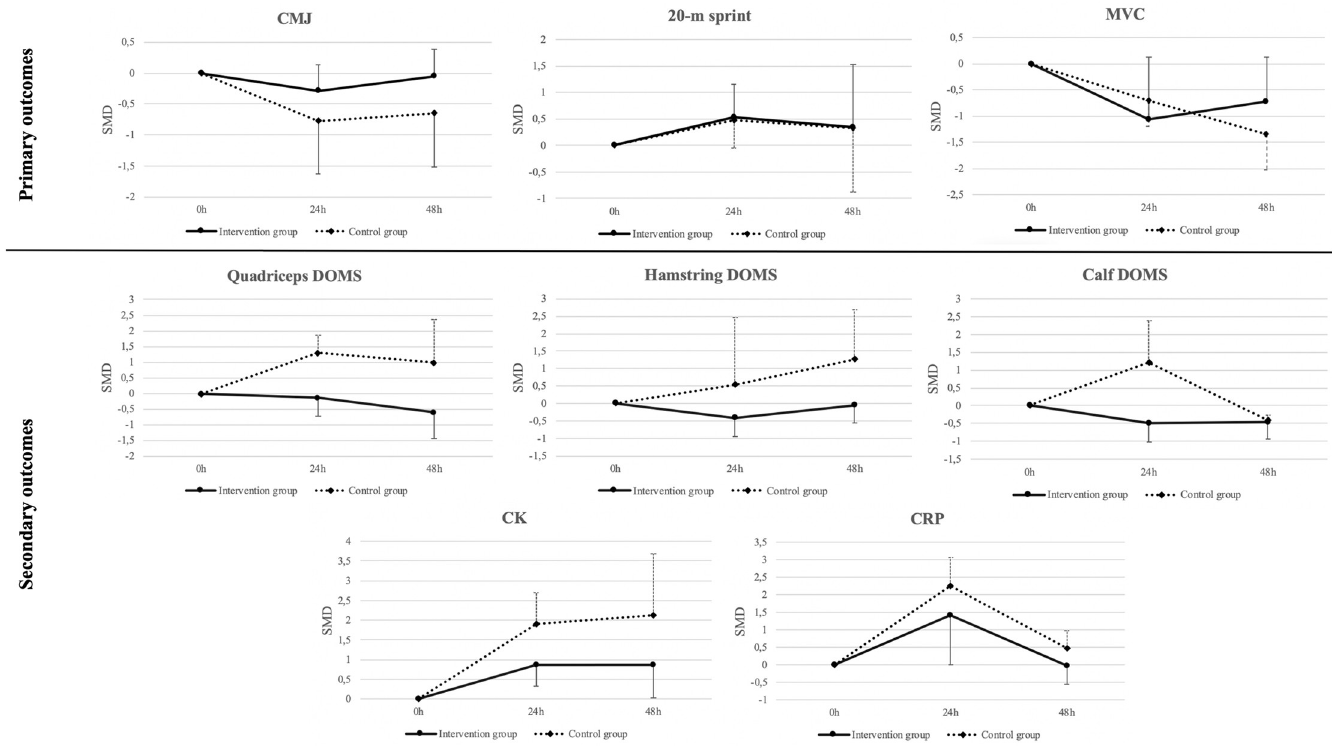
Fig 4. Time trends for primary and secondary outcomes from the experimental and control group.